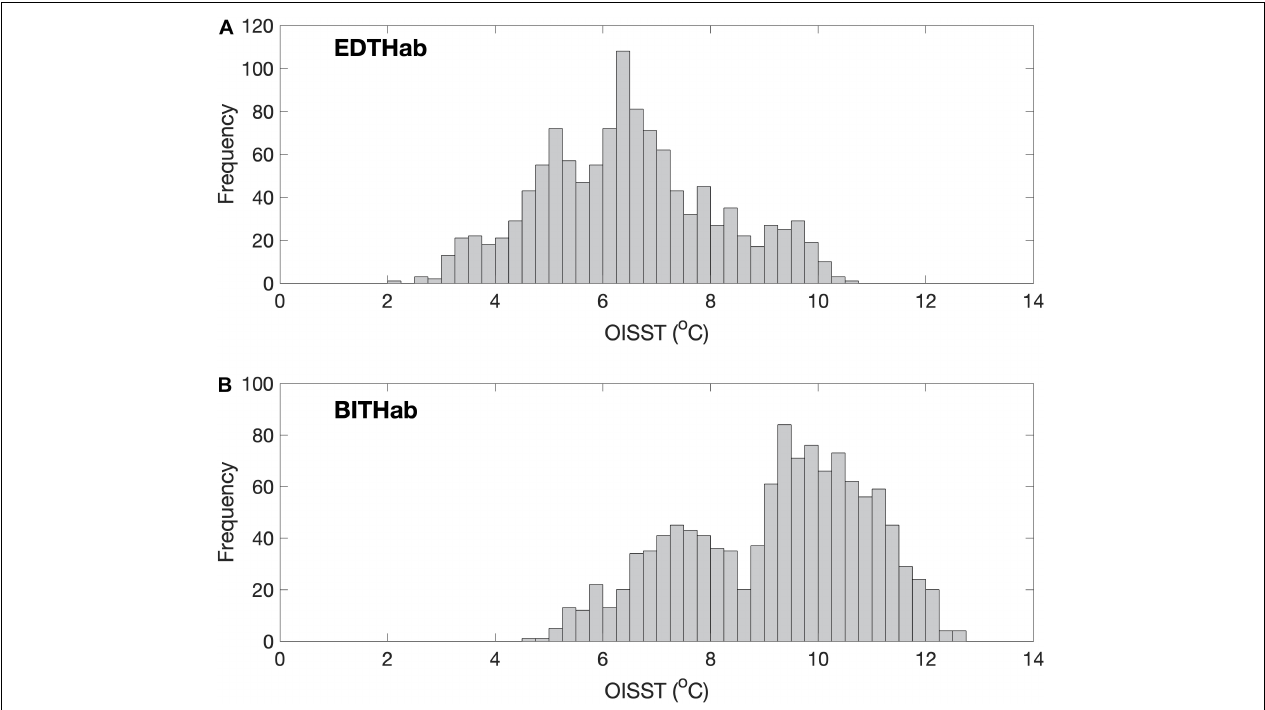
FIGURE 4 | Frequency distribution of temperature from the four OISST grid points near Wolves Islands, from where A. catenella was sampled. SST in each of the four grid points were obtained during a 11 day window centered at the respective bloom dates, over the 27-years sampling period (1988–2014). (A) Early Detection Thermal Habitat (EDTHab) using the Early Detection Dates; (B) Bloom Initiation Thermal Habitat (BITHab) using the Bloom Initiation dates. The total number of valid pixels for each habitat is